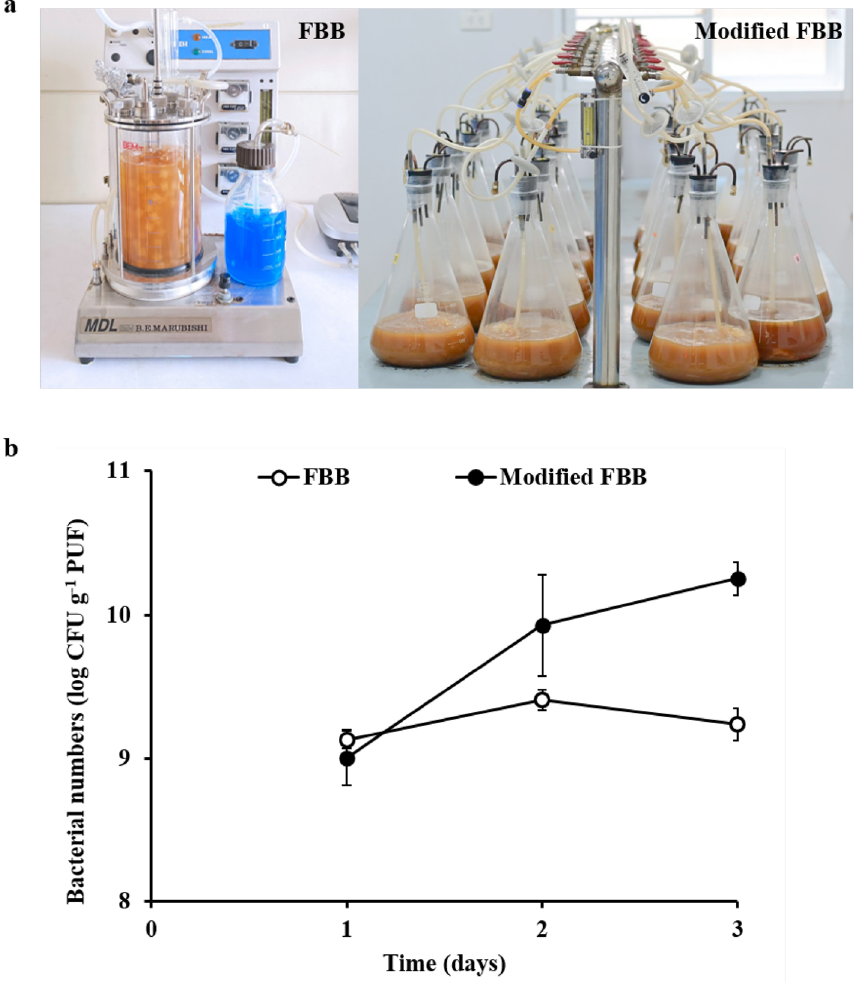
Figure 3. Image of FBR and the modified FBR for cell immobilization ( a ). Bacterial numbers of R. ruber S103 immobilized on PUF in 100%CW by a fluidized-bed bioreactor (FBB) and the modified FBB operated with filtered air at 1.50 and 2.86 L min −1 , respectively, at room temperature for 3 days ( b